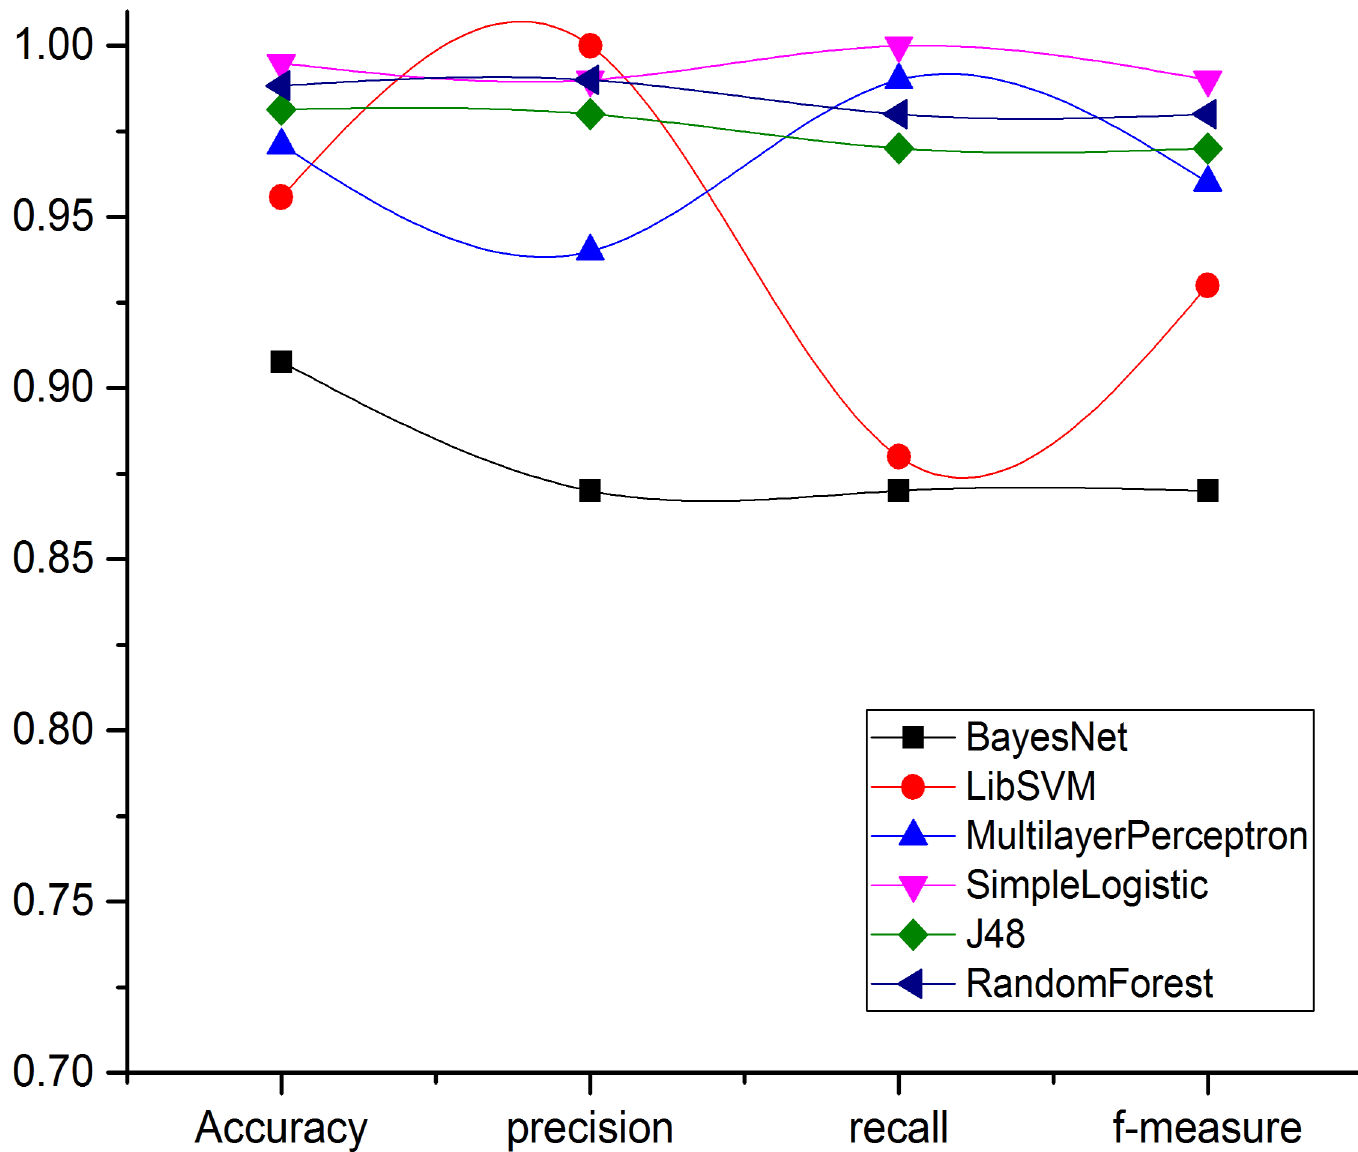
Fig 8. Overall performance comparison against each classifier for Drebin